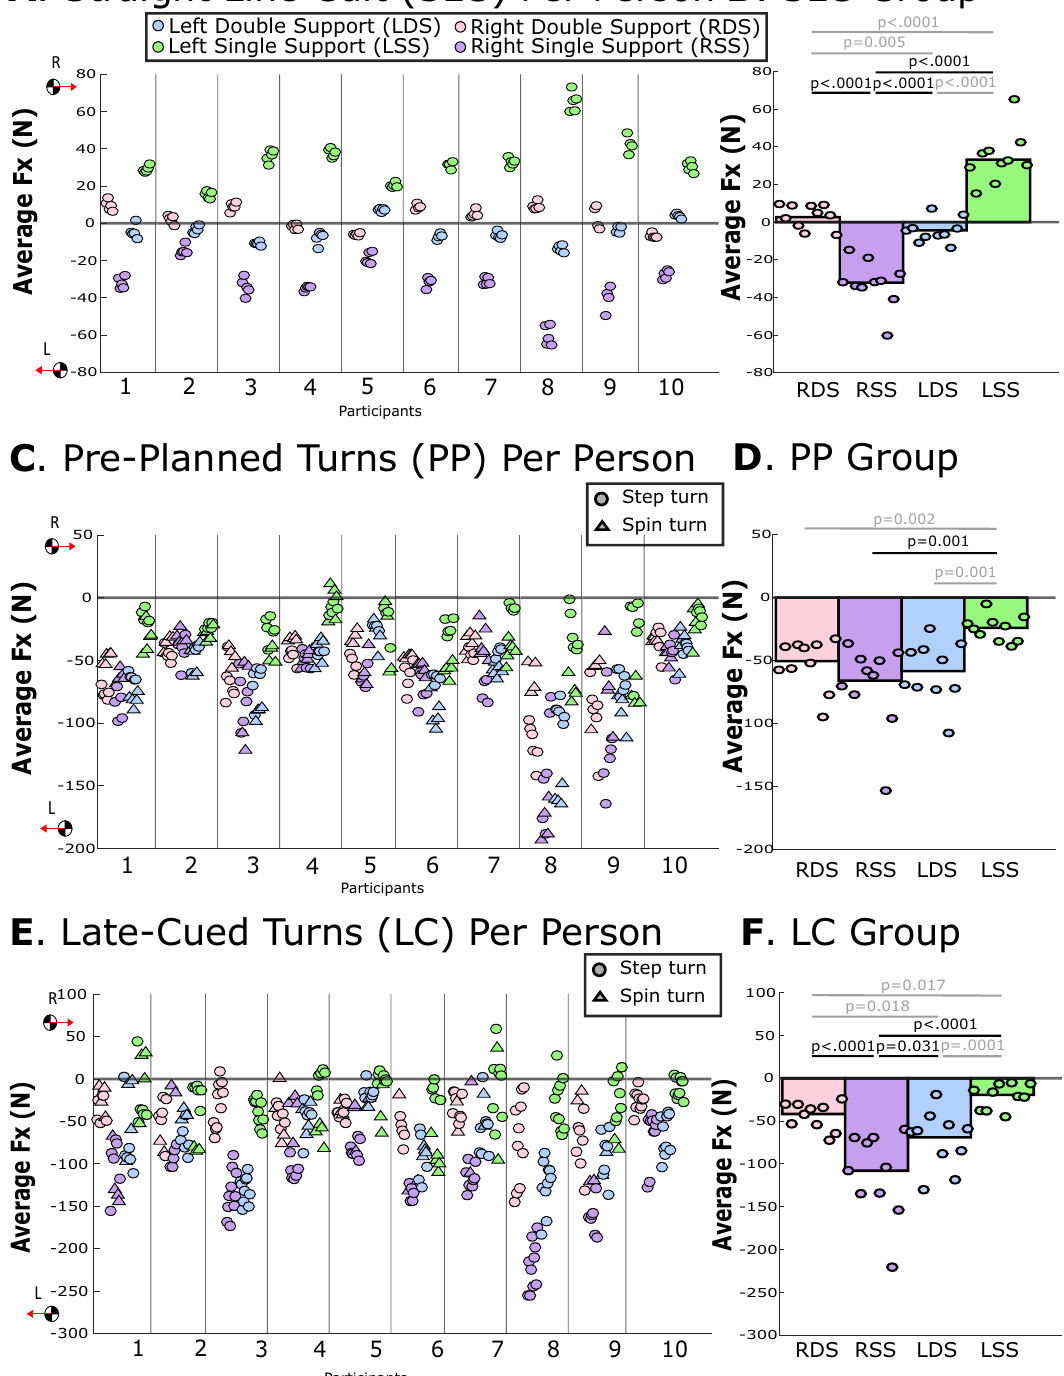
Figure 4. The average global X-axis force (F x,avg ) for each gait phase during ( A , B ) straight-line gait, ( C , D ) pre- planned turns, and ( E , F ) late-cued turns. Negative F x,avg is leftward in the direction of the turn. The left panel ( A , C , E ) provides average F x,avg for each gait phase, each trial, and each participant, with step turns indicated with circles and spin turns indicated with triangles. In the right panel ( B , D , F ), each circle indicates the average value for each participant across multiple trials and the bar represents the across-participant (group) averages. Horizontal lines with p-values indicate statistically significant differences between gait phases at the group level, those in gray are significant differences that were not related to the